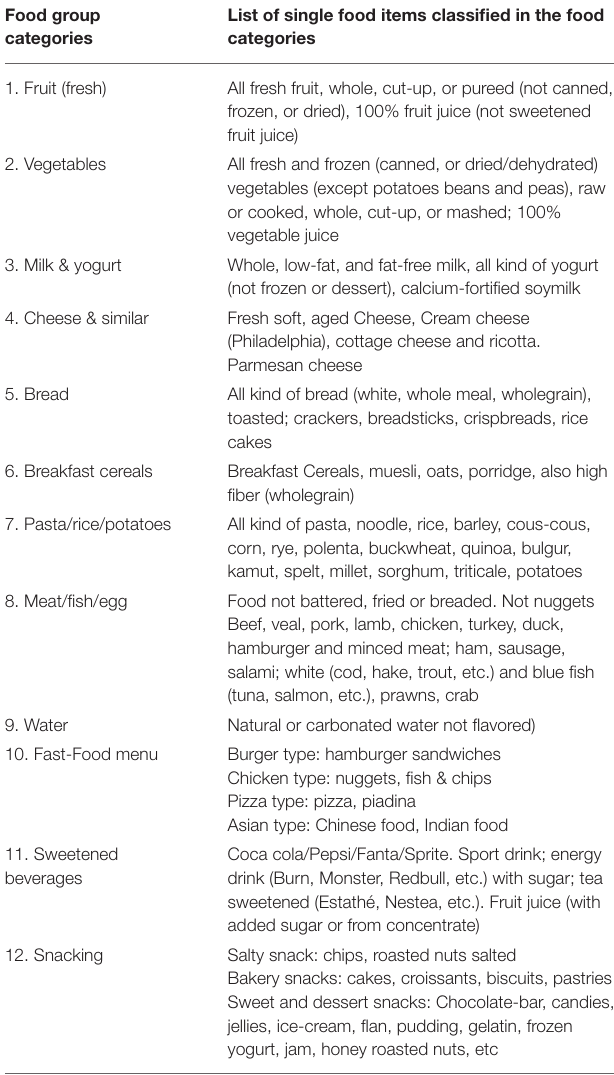
TABLE 1 | Description of food items included in food categories included in the e-Diary. Food group